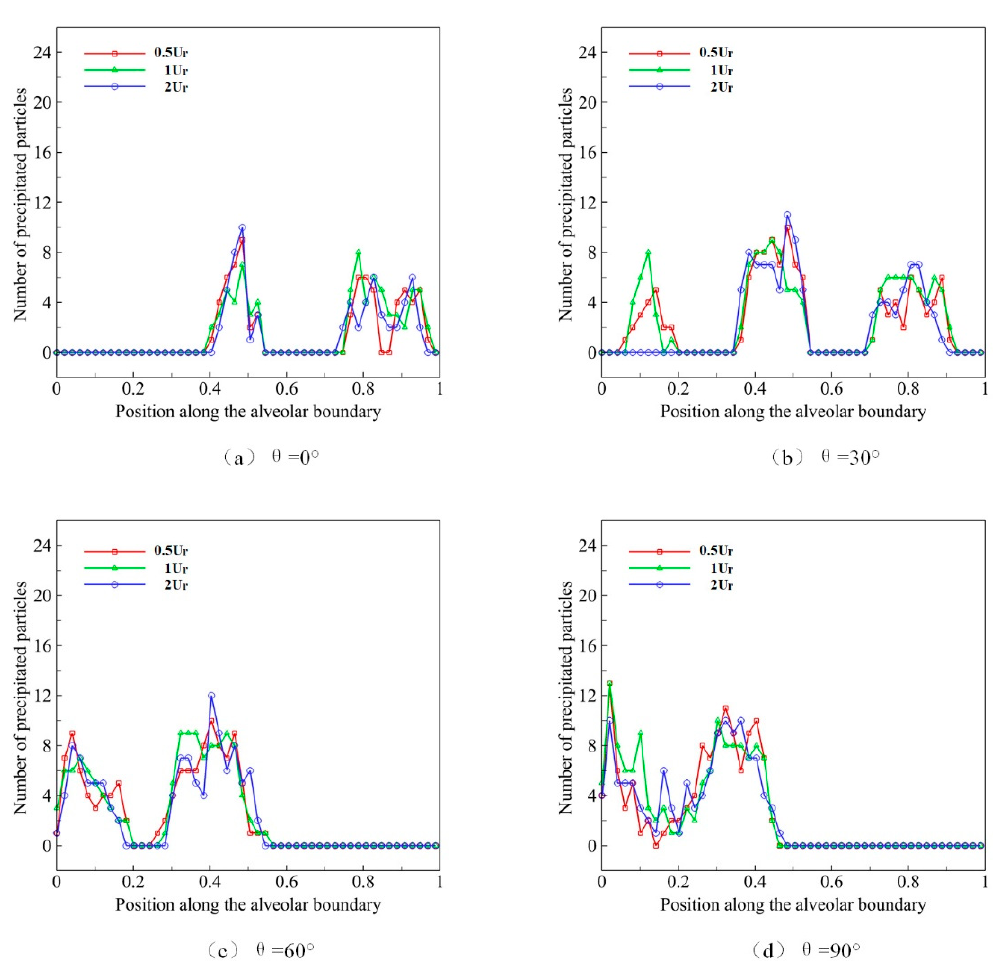
Figure 10. The deposition and distribution of microparticles in pulmonary acini at different respiratory rates.